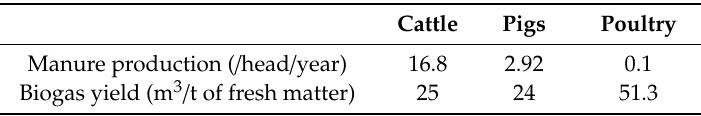
Table 1. Manure production and biogas yield coe ffi